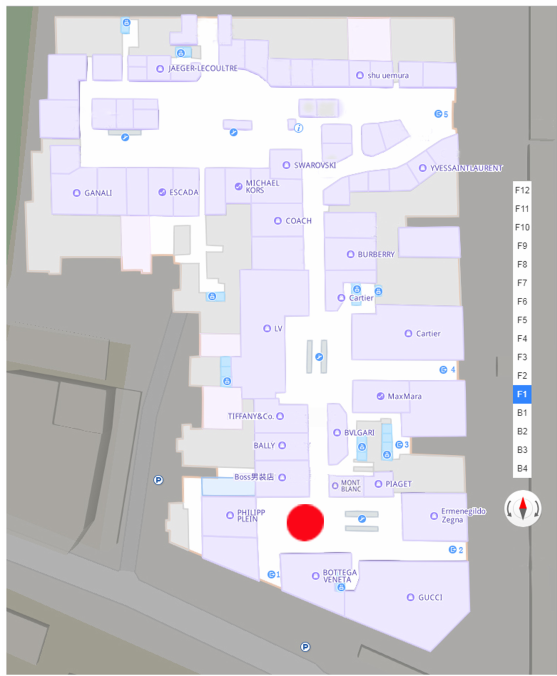
Figure 3. The AOI for self-location: the red point is the area of interest.